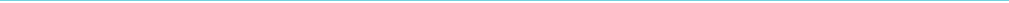
Figure 1: Combinatorial approach to enhance the efficacy of pro-senescent therapy. (A) Oncogenic stress drives growing cells into senescence. Senescent cells actively communicate with their microenvironment through the SASP. Depending on the composition of the SASP, secreted factors can either drive both autocrine and paracrine induction of senescence, or enhance the aggressiveness of neighbouring tumour cells. (B) Senescence induction in tumours treated with pro-senescence therapy. Within the tumour microenvironment, senescent tumour cells through the SASP can promote both the recruitment and activation of several immune populations, including M1-macrophages, NK cells, and Th1 cells. Such tumour-infiltrating immune subsets can restrain tumour progression by mediating the clearance of senescent tu- mour cells, and also promoting senescence. Conversely, MDSCs limit senescence induction in the tumour microenvironment by blocking senescence induction and/or anti-tumour immunity. (C) Optimisation of pro-senescence therapies for cancer. Immunotherapies may en- hance tumour clearance in tumours treated with pro-senescence therapies. Pharmacological reprogramming of the SASP may increase the anti-tumour immune response in tumours upon treatment with pro-senescence therapies. Senolytic therapies may remove senescence tumour cells in tumours where senescence surveillance is impaired, to avoid negative effects induced by the SASP. Anti-CXCR2 treatment limits MD- SC recruitment in the tumour, favouring senescence induction and/or antitumour immunity.Ochre cells represent growing cells; light-blue cells show cells undergoing to senescence; blue cells represent senescent cells; orange cells depict aggressive tumour cells.CXCR = C-X-C chemokine receptor; IFN = interferon; MDSC = myeloid-derived suppressor cells; NK = natural killer; SASP = senescence-associated secreto- ry phenotype; TGF = transforming growth factor; Th1 = type 1 helper T cells; TNF = tumour necrosis